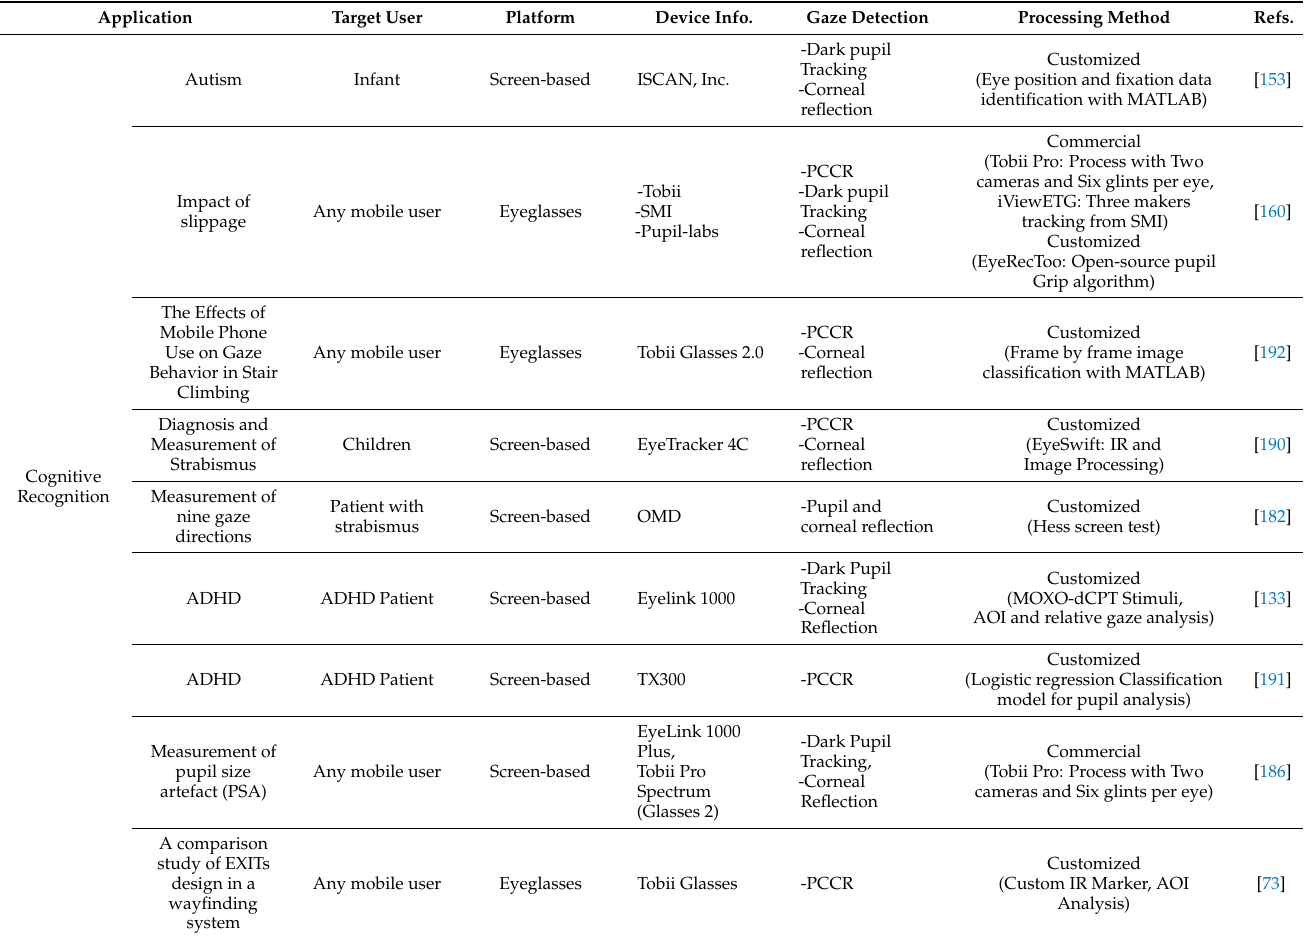
Table 4. Application examples using eye tracking